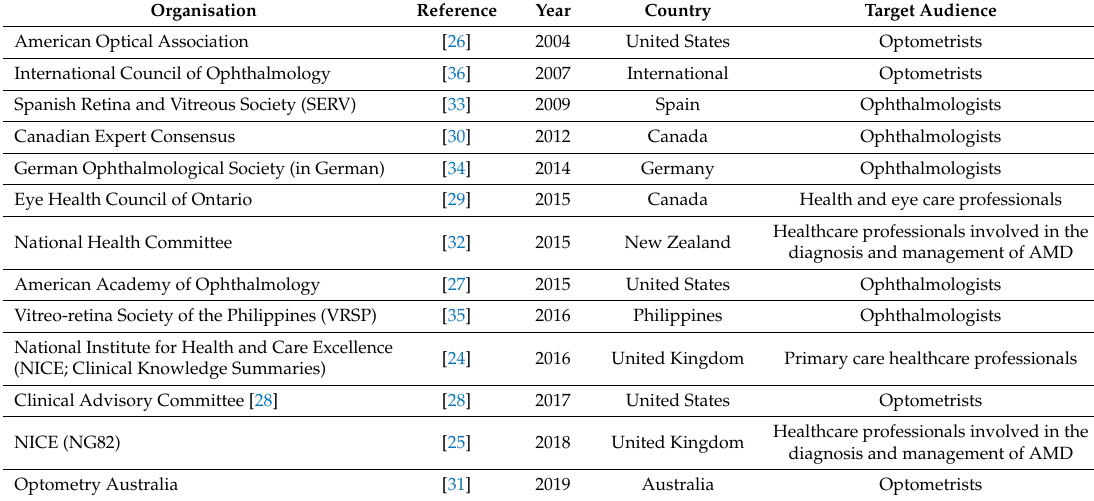
Table 2. General characteristics of the included age-related macular degeneration (AMD) clinical practice